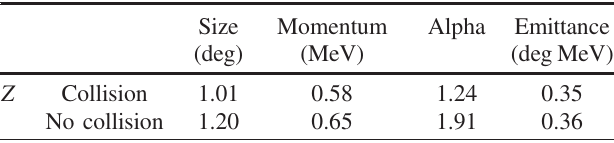
TABLE IV. Longitudinal Twiss parameters at the end of the linac with and without